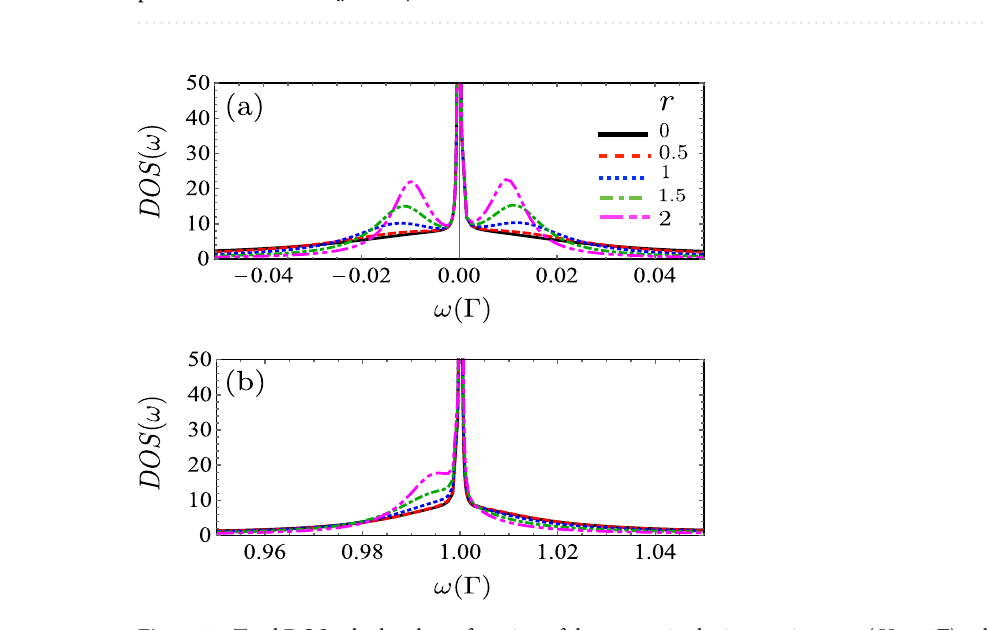
Figure 7. Total DOS calculated as a function of the energy in the interacting case ( U 0 Ŵ and ( b ) ω 1 Ŵ , and the indicated values of the rate of coupling: in a range of energy very near ( a ) ω = = 0 (black), r 0.5 (red), r 1.0 (blue), r 1.5 (green), r 2.0 (magenta). Fixed parameters: η r = = = = = 0.1 Ŵ t =